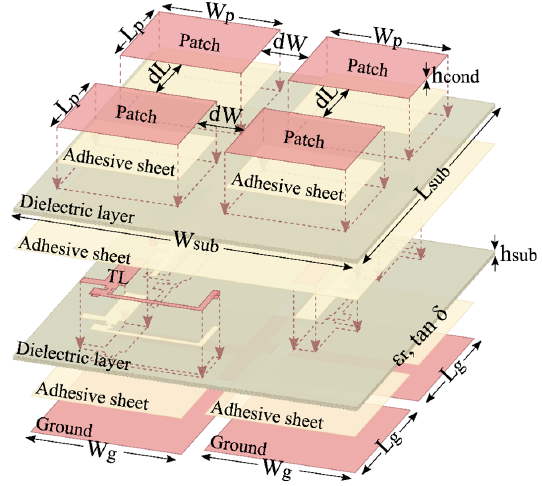
Figure 15. Proposed 2 × 2 rectenna array configuration. For clarity, all the antenna layers have been separated and labeled at the side.